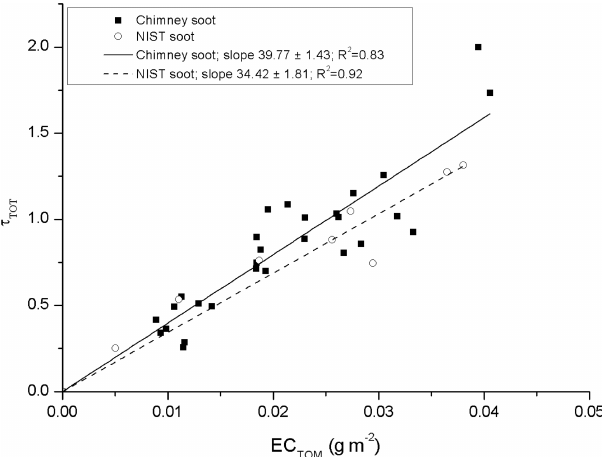
Figure 3. Comparison of the optical depth (at λ = 526nm) by Chimney and NIST soot as a function of analyzed EC density by the OCEC